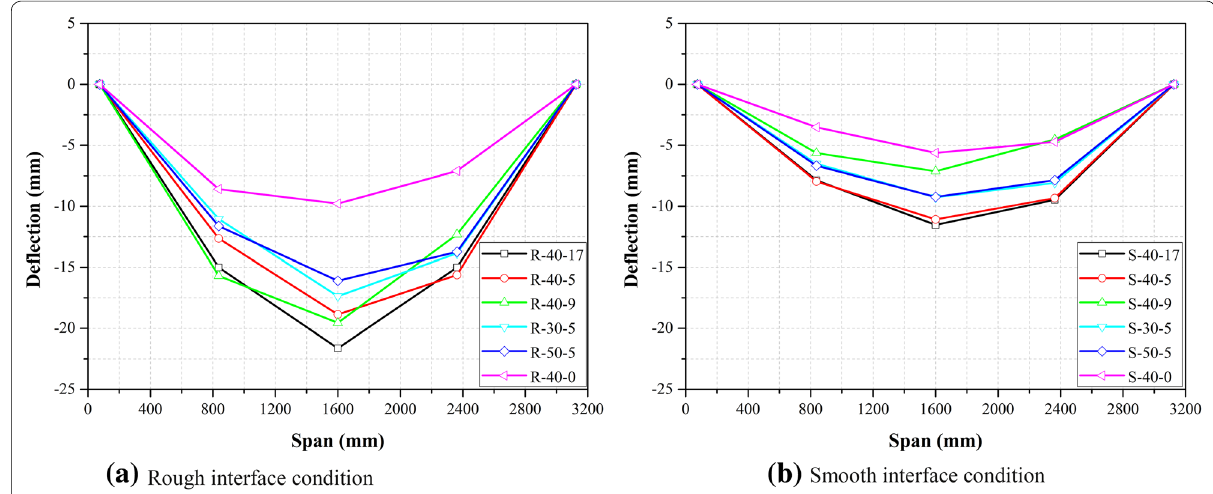
Fig. 9 Deflection curves of all beams at horizontal shear failure.